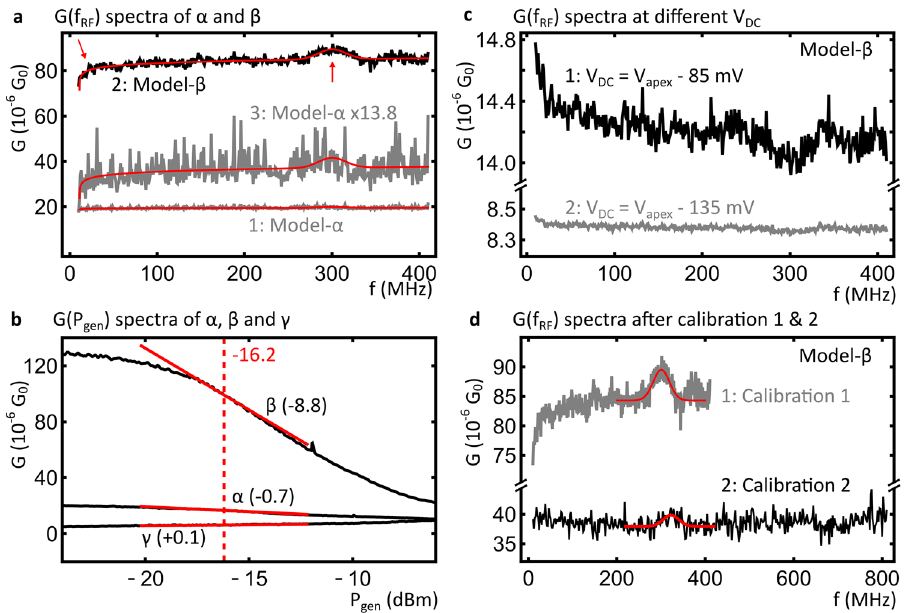
f RF Figure 2. Experimental RF conduction spectra ( a ) A comparison of experimental G spectra of models (cid:30) (cid:31) V apex of their respective G ( V DC ) spectra. The scaled (factor 13.8) and vertically offset α and β taken at V DC = copy of model-α allows for comparison of spectral details and the red curves indicate numerical fits with Eq. 1 (see text). Red arrows indicate the steady increase between 10 and 80 MHz and a peak at approximately 300 MHz in the spectrum of model-β. ( b ) Experimental G ( P gen ) curves of models α, β and γ (average of ten, five and five spectra, respectively), all acquired at constant f RF 300 MHz. The solid red lines provide a guide = 16.2 dBm. ( c ) Experimental to the eye indicating the slope of the curves in units of 10 − 6 G 0 / dBm at P gen = − V apex V apex G f RF spectra of model-β taken at V pk,jun 25 mV and V DC 85 mV (1) or V DC = − = − = (cid:30) (cid:31) f RF 135 mV (2), below the inflection point of the G ( V DC ) peak. d) A comparison of experimental G spectra (cid:30) (cid:31) V apex of their respective G ( V DC ) spectra. Red curves of model-β with calibrated V pk,jun taken at V DC = indicate numerical fits with Gaussian functions to the peaks at approximately 300 and 326 MHz, respectively. 5 S G 0 2 e / h 7.75 10 is the conductance − = ≈ ·